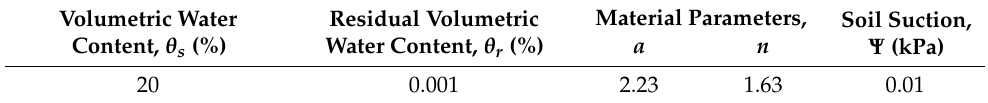
Table 2. SWCC parameters for the PFC pavement (after Lim and Kim [25] ).